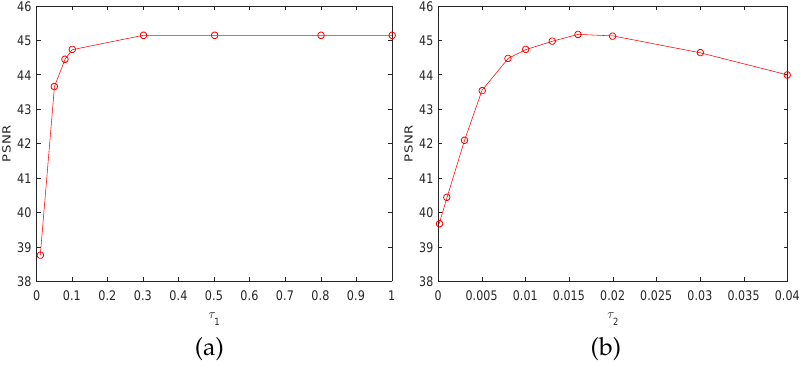
Figure 20. The PSNR curves as function of the regularization parameters. ( a ) Relationship between PSNR and the parameter τ 1 (with λ 1 = 0.005, λ 2 = 10 − 5 , τ 2 = 0.01); ( b ) relationship between PSNR and the parameter τ 2 (with λ 1 = 0.005, λ 2 = 10 − 5 , τ 1 =